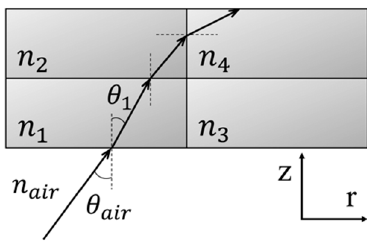
Figure 2. Modeling for ELC diffuser analysis. The LC layer is divided into grids. The behavior of LC molecules and the corresponding refractive index are calculated in each grid.